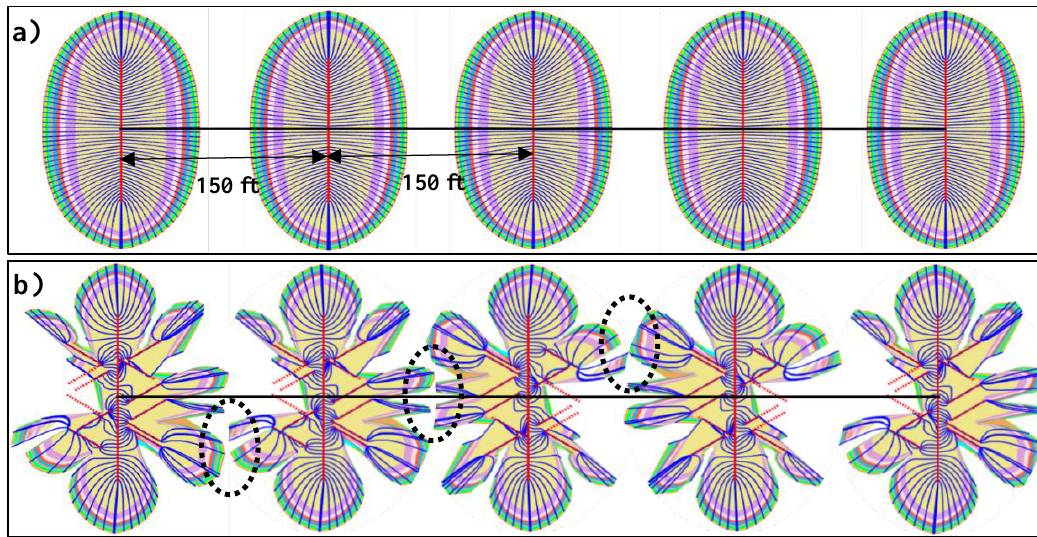
Figure 14. ( a ) Plan view of DRV for modeled well using a possible stage spacing of 150 ft assuming homogenous reservoir ( b ) Plan view of DRV for multiple stages using 150 ft spacing with the impact of natural fracture modeled using HFTS data. Hydraulic fracture in red line; natural fractures in dashed red line; streamlines in blue. Rainbow colored fill shows drained areas after 3-year time periods. Dashed ellipses in black show overlapping of DRV’s that can cause unwanted flow interference.